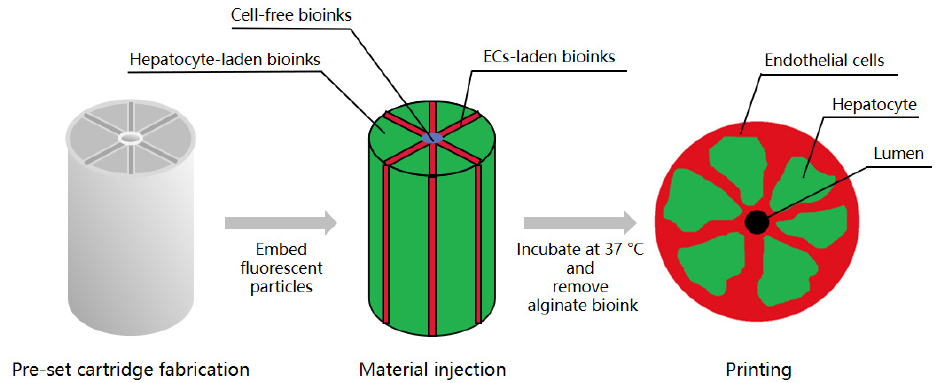
Figure 2. Overview of the protocol for the generation of a hepatic lobule array. Kang et al. fabricated a preset cartridge and injected hepatocyte-laden bioinks, ECs-laden bioinks, and cell-free bioinks into it to imbed HepG2/C3A and ECs. Then, they removed the alginate bioink to form a lumen. After incubation at 37 °C, ECs covered the outside of the construct, forming a lumen in which ECs were lined and interconnected between the exterior and the lumen.